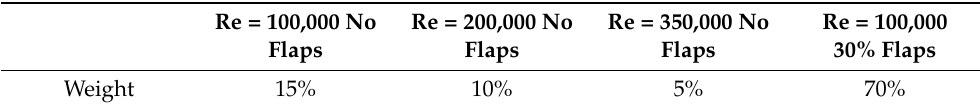
Table 10. Weights of each Re, towards final airfoil stall quality calculation. Re = 100,000